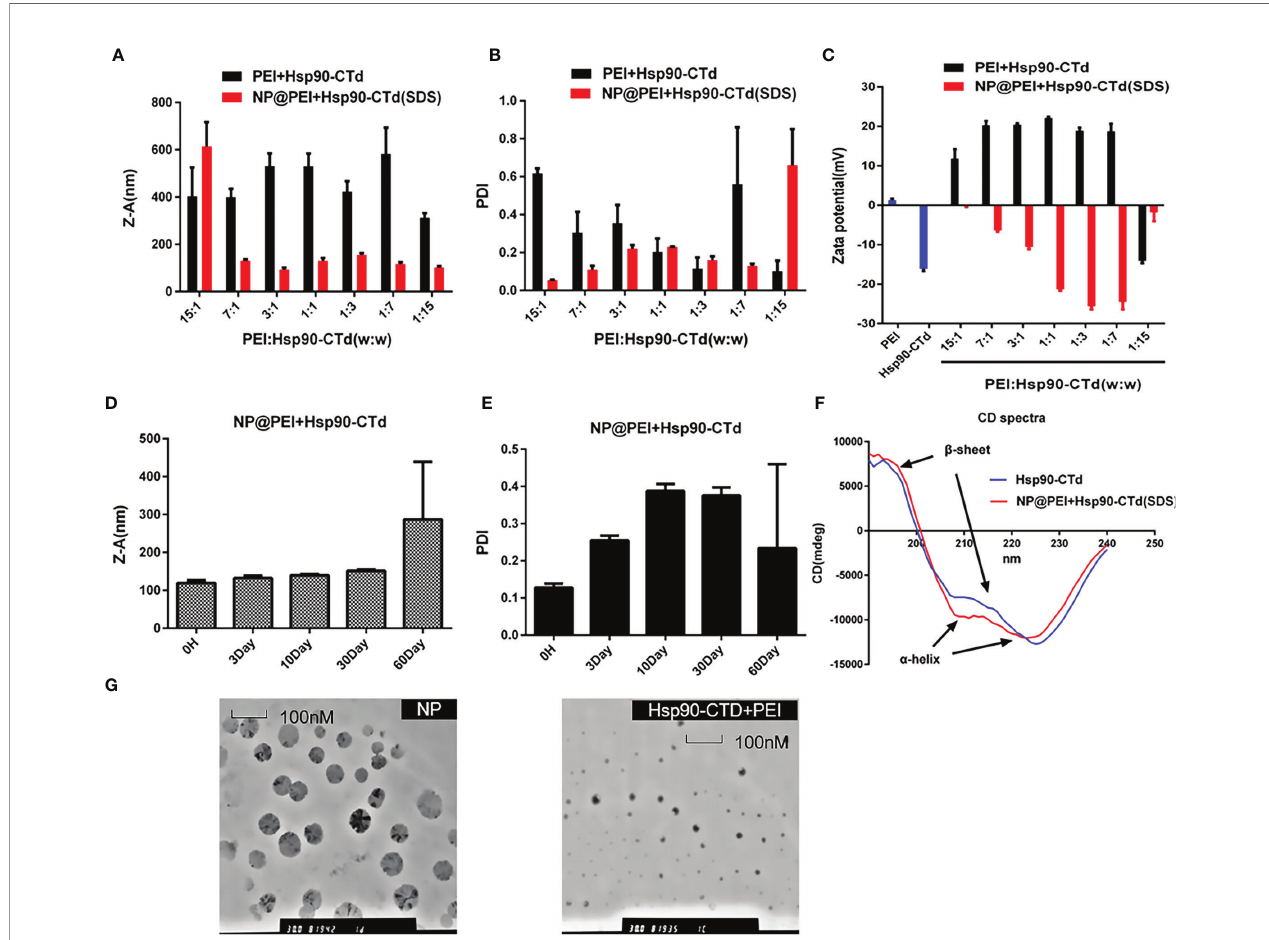
FIGURE 2 | Synthesis and characterization of the particles. (A) Size of different proportions (PEI: Hsp90-CTD) nanoparticles after treating with SDS. (B) PDI of NP@PEI+Hsp90-CTD nanoparticles after treating with SDS. (C) Surface zeta potential of nanoparticles. The nanoparticles ’ stability of (D) size, and (E) PDI stored at 4°C for a month. (F) Comparable results between pure protein and SDS-modi fi ed protein were obtained by circular dichroism (CD) spectroscopy. (G) TEM images of NP@PEI+Hsp90-CTD and particles without SDS